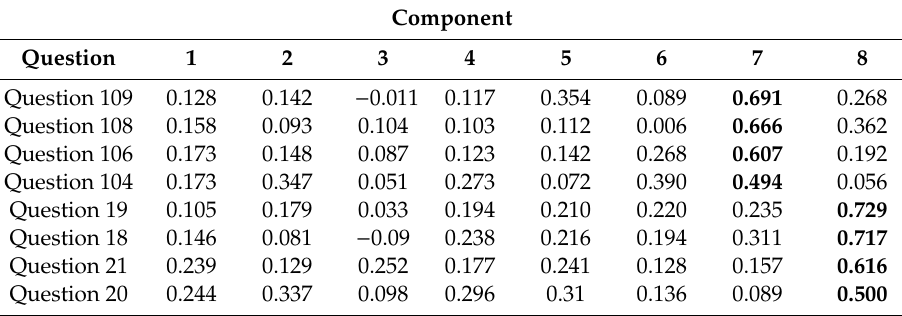
Table A2. Cont . Component